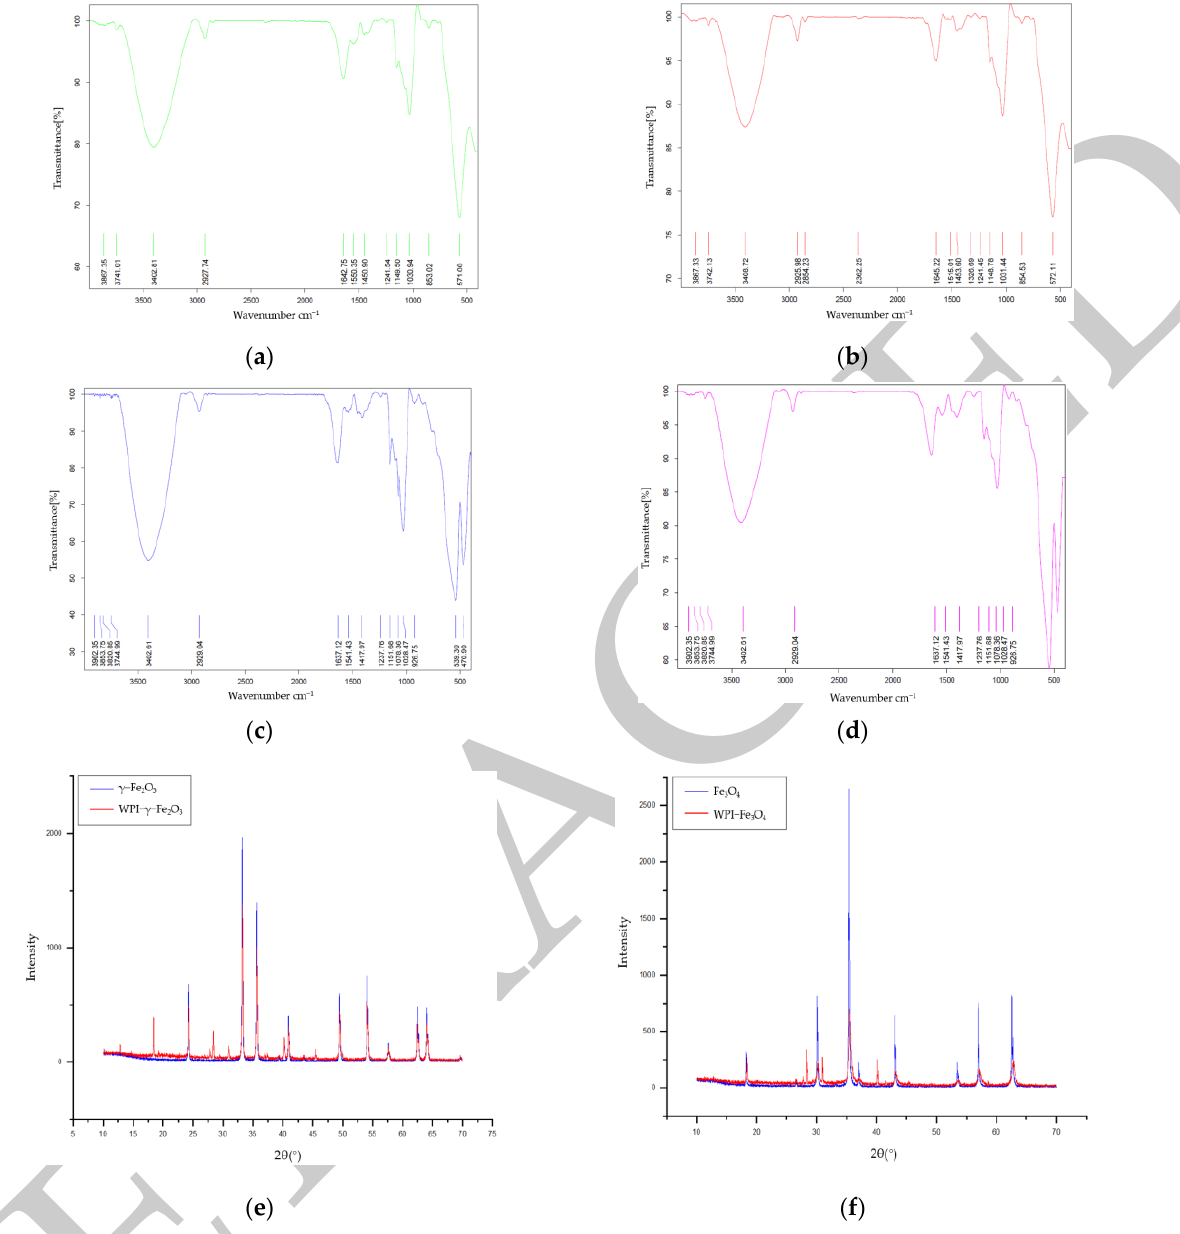
Figure 2. Characterization of WPI−SNPs: ( a ) FTIR spectra result of the original γ−Fe 2 O 3 ; ( b ) FTIR spectra result of the modified WPI−γ−Fe 2 O 3 ; ( c ) FTIR spectra result of the original Fe 3 O 4 ; ( d ) FTIR spectra result of the modified WPI−Fe 3 O 4 ; ( e ) XRD comparison result of γ−Fe 2 O 3 and WPI−γ−Fe 2 O 3 ; ( f ) XRD comparison result of Fe 3 O 4 and WPI−Fe 3 O 4 .